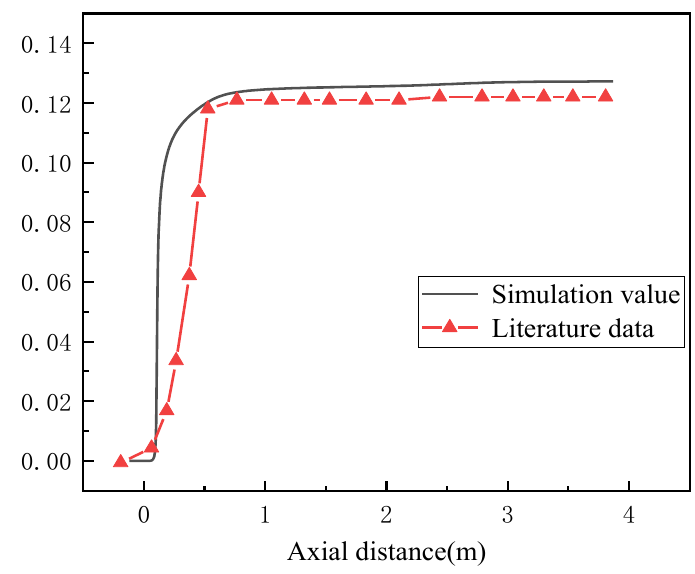
Figure 4. Comparison of axial mole fraction distribution of CO 2.